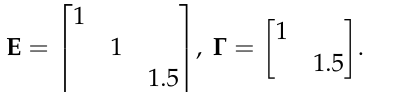
Figure 8. Desired path. ( a ) Single-line-change condition; ( b ) Double-line-change condition. Scenario 1 : The Single line-change condition at 80 km/h. Where DT represents the de- sired trajectory, LQ-S represents the simulation result of the linear quadratic controller, the fuzzy LQ-S represents the simulation result of the fuzzy linear quadratic controller, LQ-HIL represents the experimental result of the linear quadratic controller, and fuzzy LQ-HIL represents the experimental result of the fuzzy linear quadratic controller. The initial weight of the cost function is set